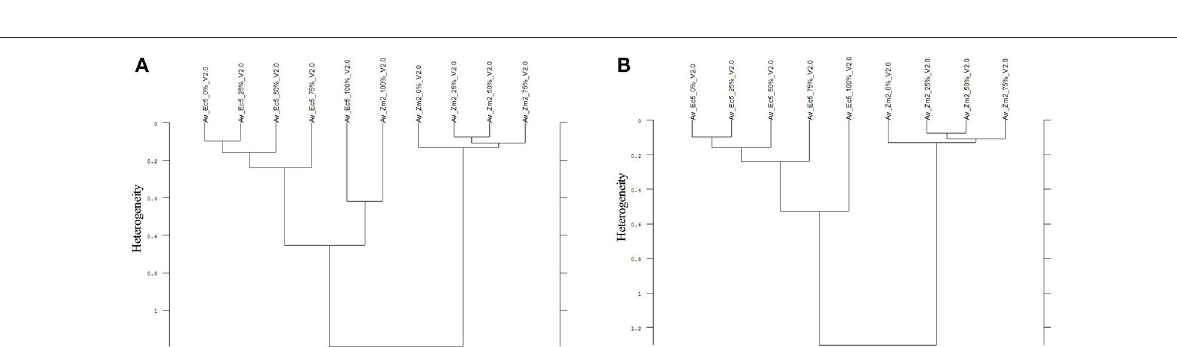
FIGURE 2 | Cluster analysis of the Av-spectra of the 1:1 comparision of (A) Pisum sativum (Ps, pea) and Avena sativa (As, oat) as well as (B) Zea mays (Zm, maize) and Echinochloa crus-galli (Ec, barnyard grass). Here exemplarily represented Ps3 and As3 of experiment 1-2 (A) as well as Zm3 and Ec1 of experiment 2-2. Entire results are shown in Supplementary Tables 1, 2. Cluster analysis was evaluated with the first derivation and vector normalization of the reduced frequency range (3,751–2,749 cm − 1 and 1,801–599 cm − 1 ), Ward’s algorithm and Euclidian distance. The Av-spectra are averages (Av) of FTIR-ATR spectra of the different root segments (100% root tip, 0% root basis etc.; see Figure 1 for scheme, Table 2 for n, Table 1 for names of cultivars and proveniences).